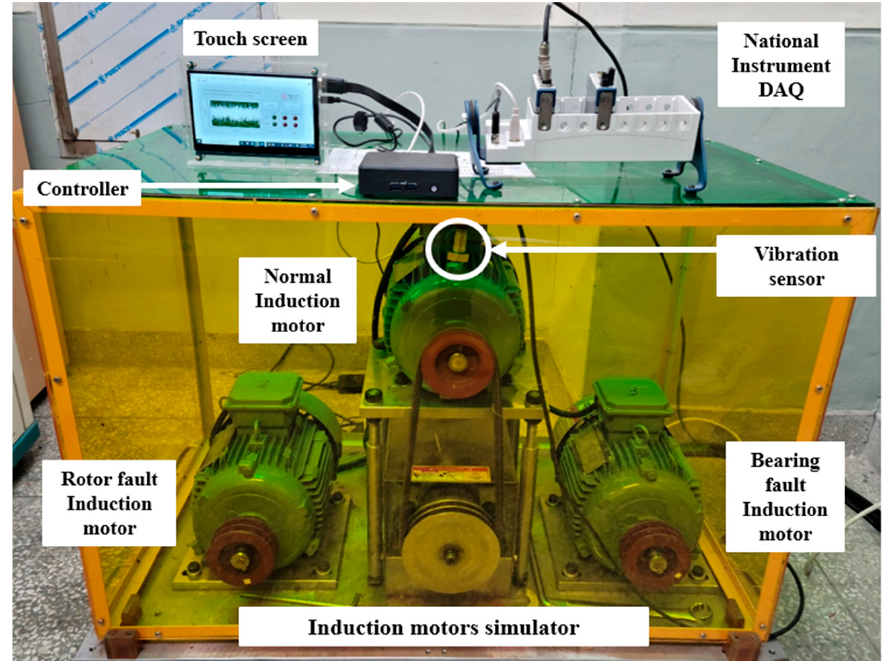
Figure 1. Experimental laboratory setup.